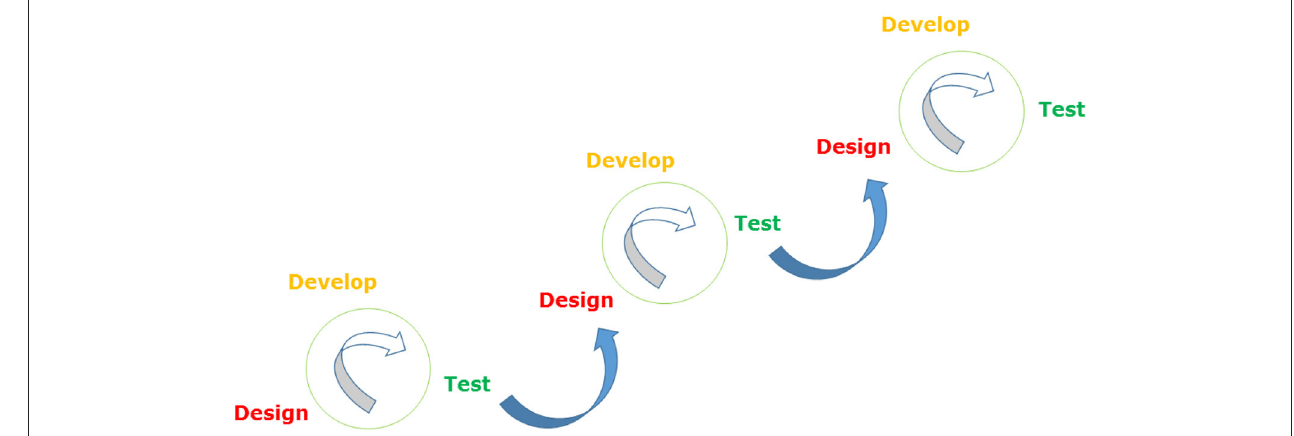
FIGURE 1 | The agile